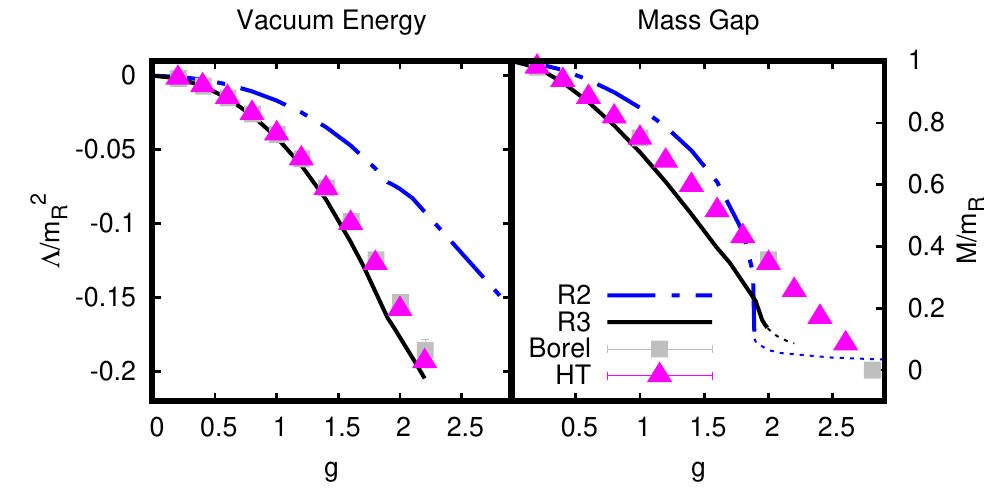
Figure 1 . Vacuum energy and mass gap for scalar (cid:30) 4 in 1+1 dimensions as a function of dimensionless coupling g = (cid:21) . Results are shown for the R2 and R3 approximation (dashed and m 2 R full lines, respectively) and precision calculations from Borel summation (’Borel’) and Hamiltonian truncation (’HT’) from refs. [7, 8], respectively. Mass-gap results for R2 and R3 results become resolution-dependent for small mass (dotted lines). See text for